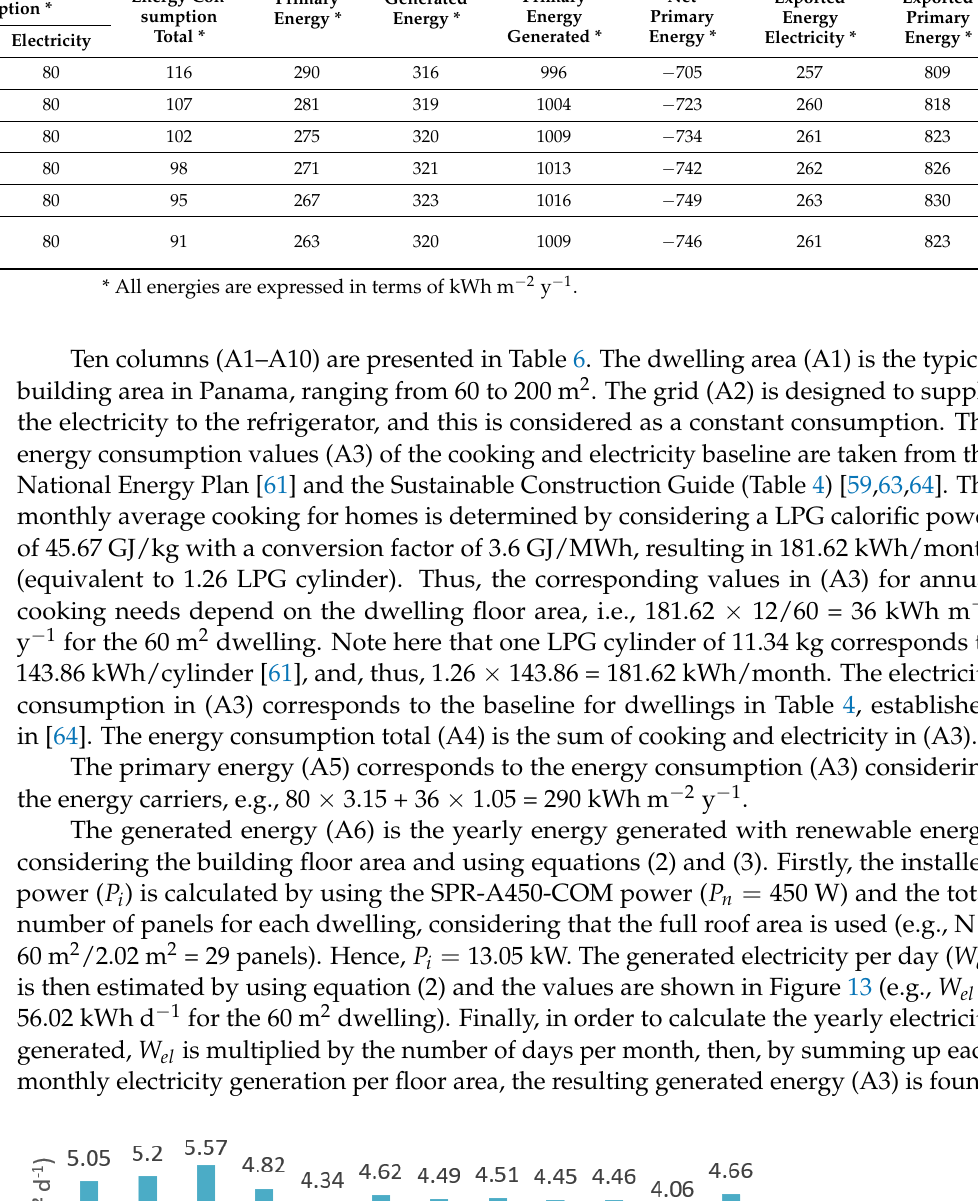
Table 6. Energy consumption and balance in typical residential building.